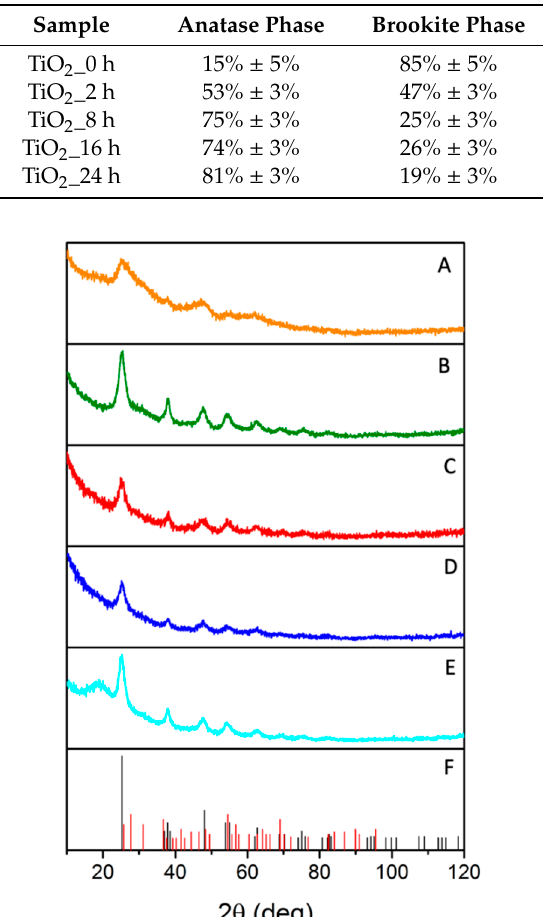
Figure 2. XRD experimental patterns of as prepared TiO 2 nanoparticles (NPs) before ( A ), and after the thermal treatment in an oven at 110 °C for 2 h (( B ), TiO 2_ 2 h), 8 h (( C ), TiO 2_ 8 h), 16 h (( D ), TiO 2_ 16 h) and 24 h (( E ), TiO 2_ 24 h). Bragg hkl reflections positions for anatase phase (black line, panel ( F )) and brookite phase (red line, panel ( F )) respectively, are reported. Table 1. Crystallographic composition of the TiO 2 NPs as a function of the duration of the thermal treatment.